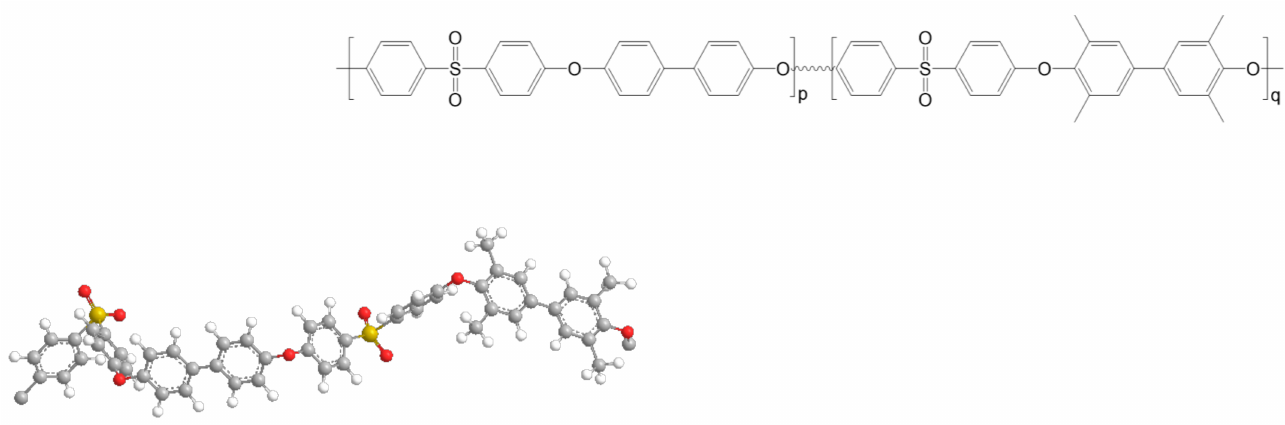
Figure 1. Schematic of Polyphenylsulfone/Tetramethylbiphenol polysulfone (PPSU/TMPPSf) copolymers. p represents the mole fraction of PPSU, and q represents the mole fraction of TMPPSf in copolymers (q = 0, 0.46, 0.64, or 0.74 in this